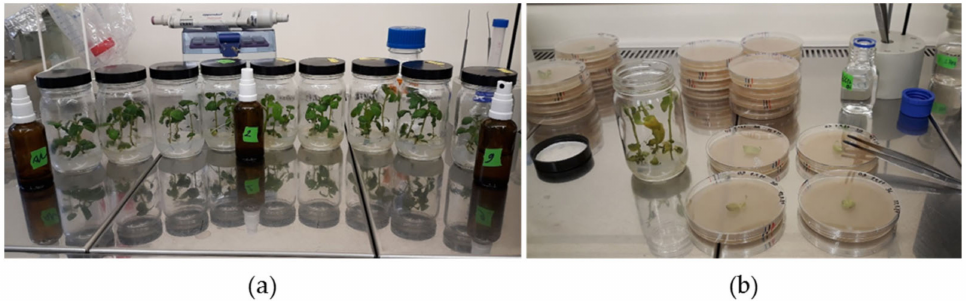
Figure 6. Inoculation of Phytophthora infestans on susceptible potato cultivar Dobrin in vitro. ( a ) Four to five week old in vitro plantlets of Dobrin were used to maintain virulence of P. infestans isolates before experiments. Zoospore suspension was inoculated using 50 mL glass spray bottles. ( b ) Five to six days post inoculation mycelium-covered leaflets were transferred to Rye-A+